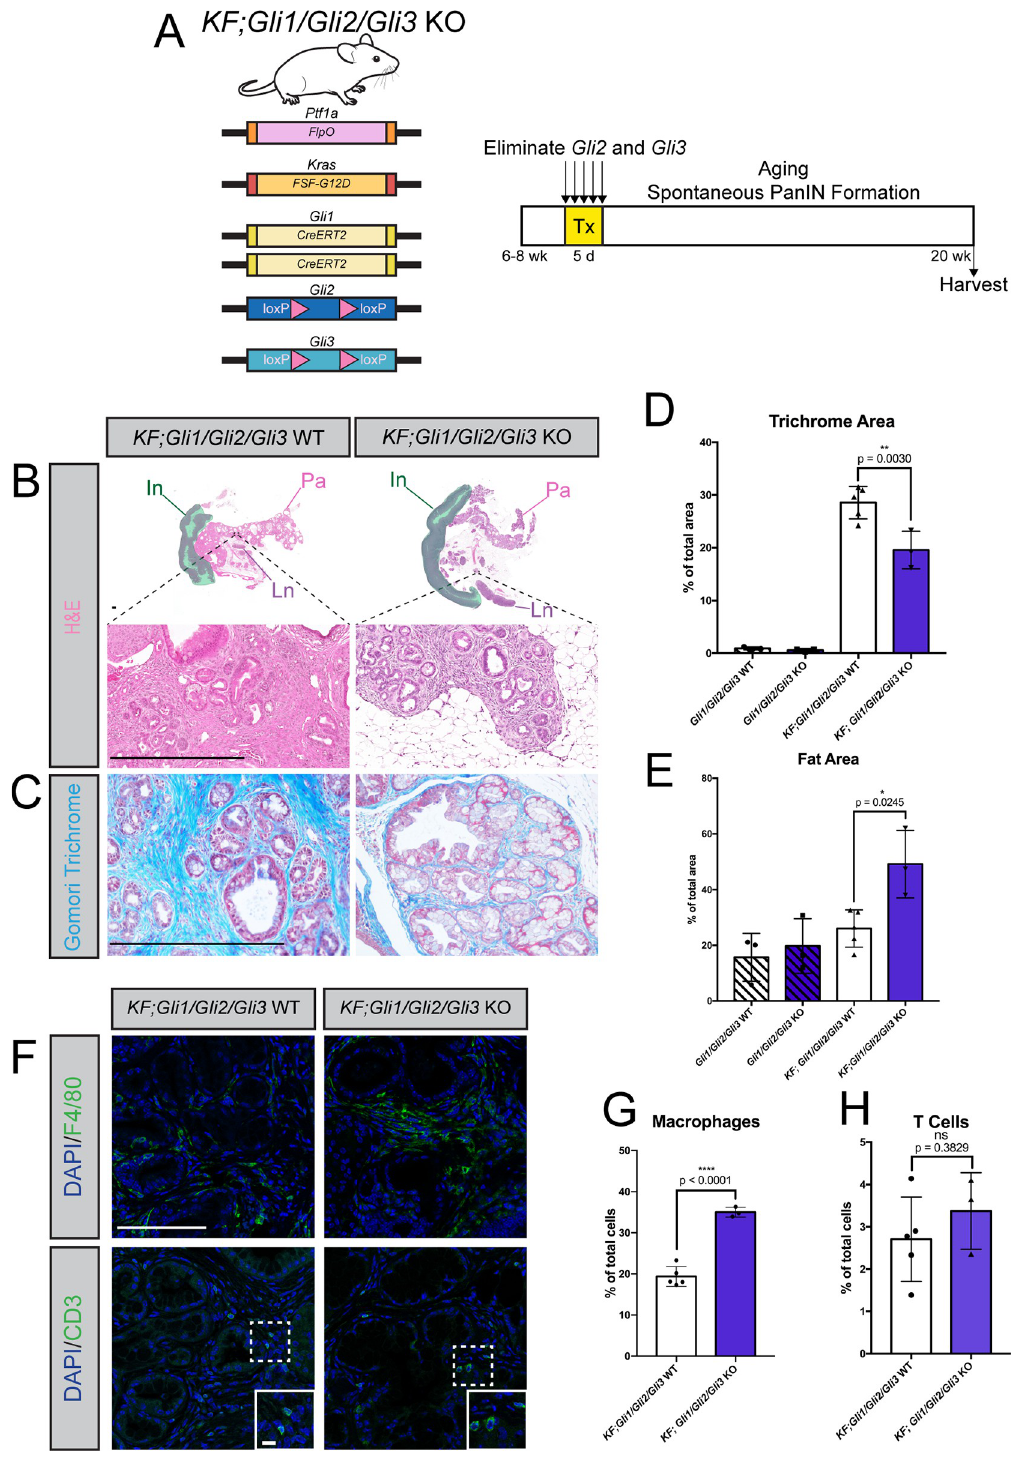
Fig 4. Combined Gli1-3 deletion drives widespread tissue loss during PanIN progression. A ) Cartoon depicting experimental strategy. Adult KF; Gli1 CreERT2/CreERT2 ; Gli2 fl/fl ; Gli3 fl/fl ( KF;Gli1/Gli2/Gli3 KO) mice were given tamoxifen (Tx, 200mg/kg) once a day for 5 days. Pancreata were harvested at 20 weeks of age. B-E ) Histological analysis of KF; Gli2 fl/fl ; Gli3 fl/fl ( KF;Gli1/Gli2/Gli3 WT) (left) and KF;Gli1/Gli2/Gli3 KO (right) mice, including H&E staining ( B ), Gomori trichrome ( C, quantified in D ), and fat area ( E ). Green shaded area outlines intestinal tissue (In). Pancreas tissue (Pa) and Lymph nodes